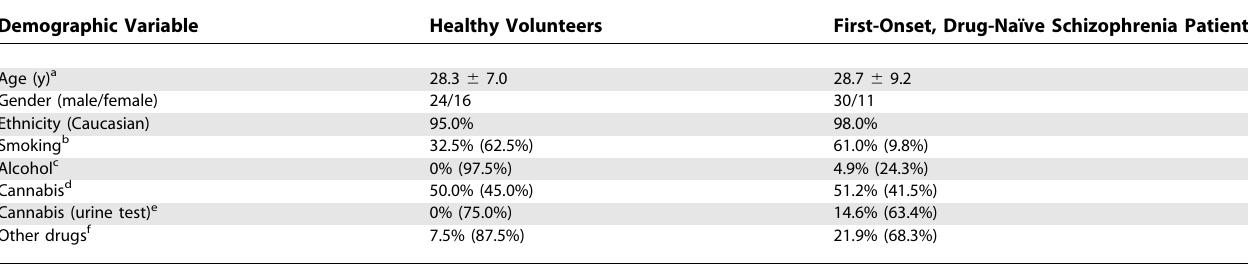
Table 1. Demographic Details of Subjects in the First CSF SELDI Experiment Demographic